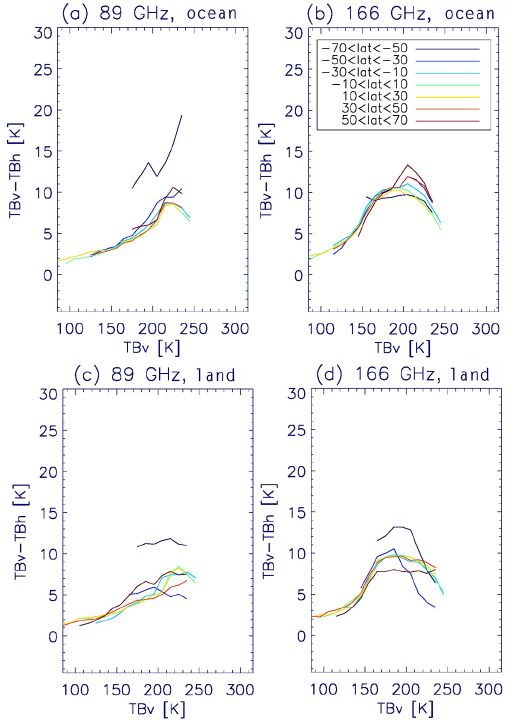
Figure 4. The PDF peak curves from different latitude belts (see la- bel) derived from June–July–August 2014 and 2015 climatologies. Top panels for ocean and bottom panels for land conditions, respec- tively. The surface signal is removed using the 183.3 ± 3GHz radi- ance and the 3 σ threshold